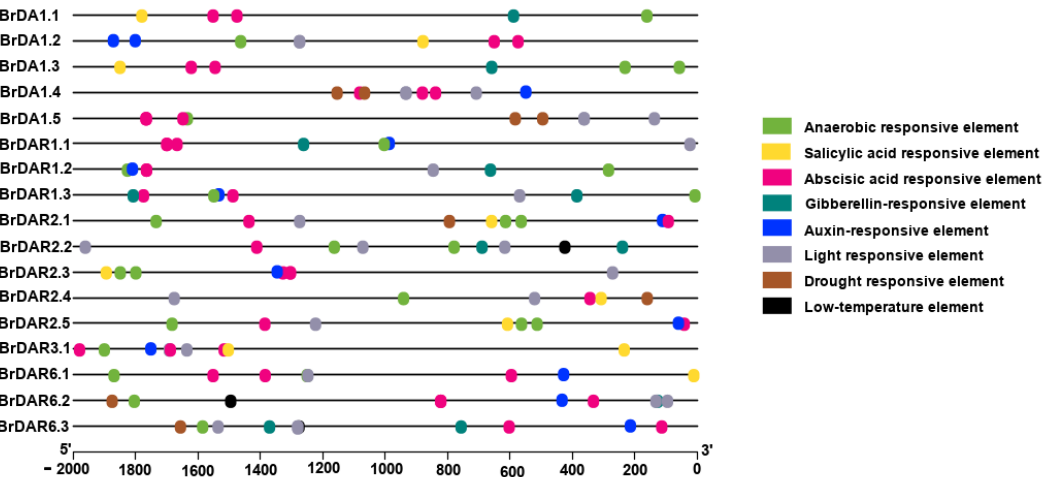
Figure 5. Different abiotic stress (anaerobic, light, drought, low temperature) and phytohormone (SA, ABA, GA, IAA) related cis -regulatory elements in BrDA1 & DAR . Boxes of different colors show the different identified elements.